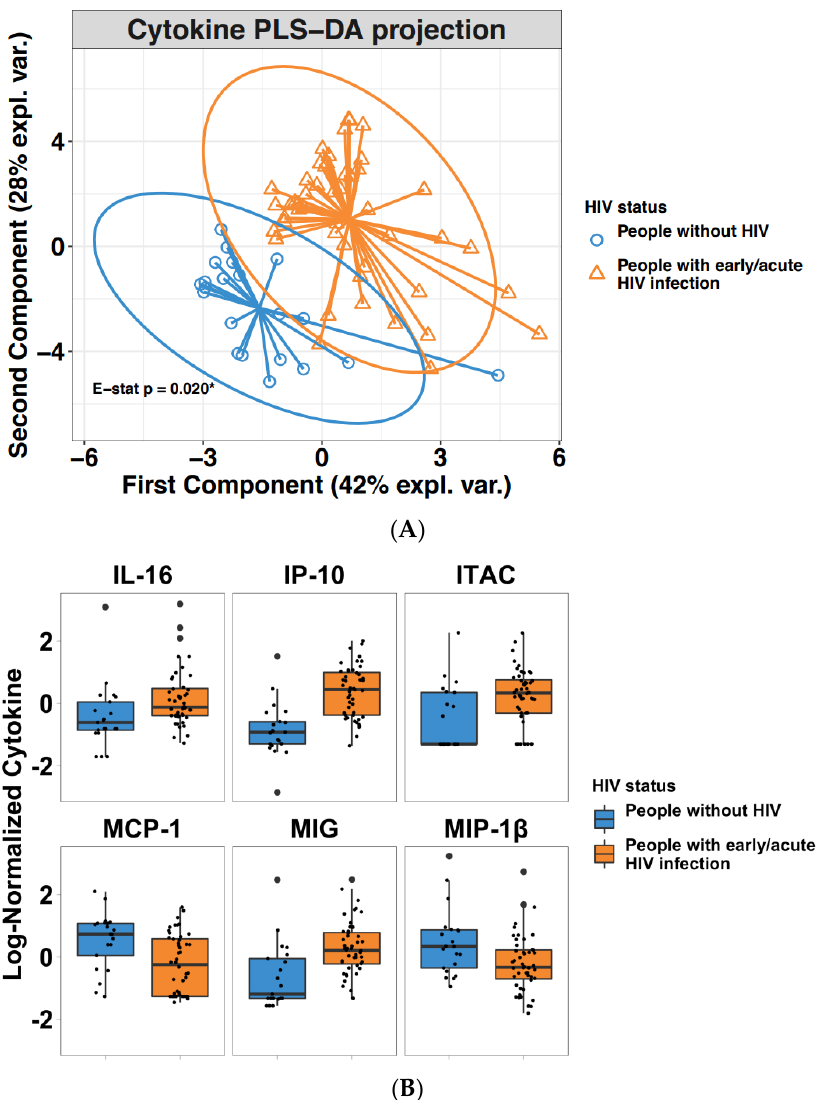
Figure 1. ( A ) Two-dimensional PLS projections of blood cytokines in people with and without HIV. Shown are PLS-DA projections in two LVs with ellipses representing Hotelling’s 2-samples T2 with 95% confidence intervals in blood plasma for people with early/acute HIV (orange triangles) or without HIV (blue circles). The E-statistic was used to test the statistical differences in the separation between the cytokine profiles of the two groups. The multivariate distance between people with and without HIV was significant ( p = 0.02). ( B ) Effect of early/acute HIV infection on chemokines/cytokines in blood. The statistical significance of 12 cytokines with VIP > 1 identified in the PLS-DA model were tested by Wilcoxon Rank Sum test. Six out of 12 remained significant. Shown is the difference of the log10-transformed concentrations of the 6 chemokine/cytokines in people with or without HIV and plotted as boxplots. For each cytokine and each boxplot, each point represents a participant’s cytokine concentration, the box represents the interquartile range (IQR), the middle line represents the median, while the points beyond the whiskers are outliers.